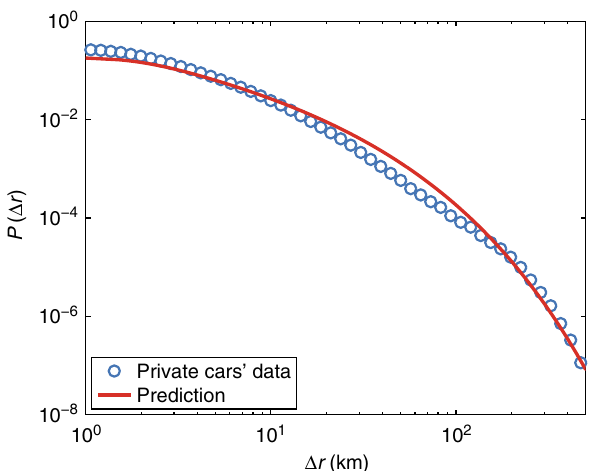
Figure 5 | Displacements distribution. We show (circles) the aggregated empirical distribution P ( D r ) for all the E 780,000 cars in the data set. The solid line is the model prediction (and not an a posteriori best fit) based on our model equation (5) with: (i) v 0 ¼ 17.9kmh (cid:2) 1 estimated as the intercept of the fit in Fig. 2; (ii) p 0 ¼ 1.06 jumps per hour and d v 0 ¼ 20.9kmh (cid:2) 1 estimated from the fit of P (cid:2) v t jð Þ in Fig. 4; and (iii) (cid:2) t ¼ 0.30h coming from the average of the travel times for all selected trips (see Methods section). This remarkable prediction has a quality comparable with the commonly used direct fits by a truncated power law with three free parameters (see Supplementary Fig.